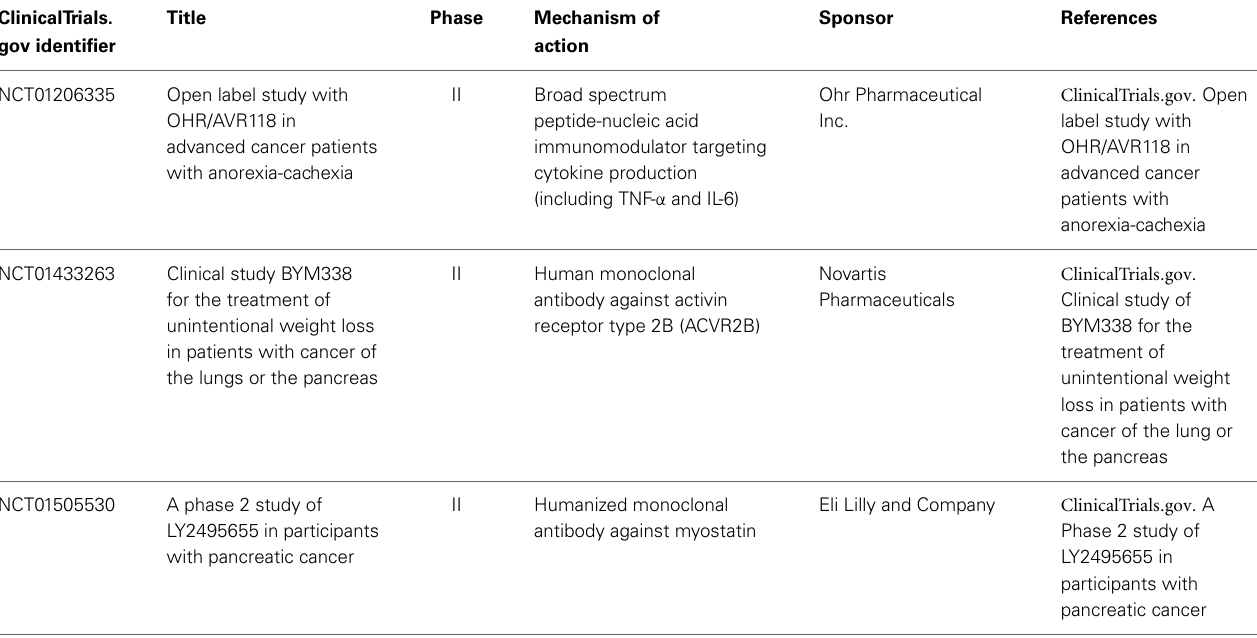
Table 4 | Investigational drugs for the treatment of cancer cachexia.